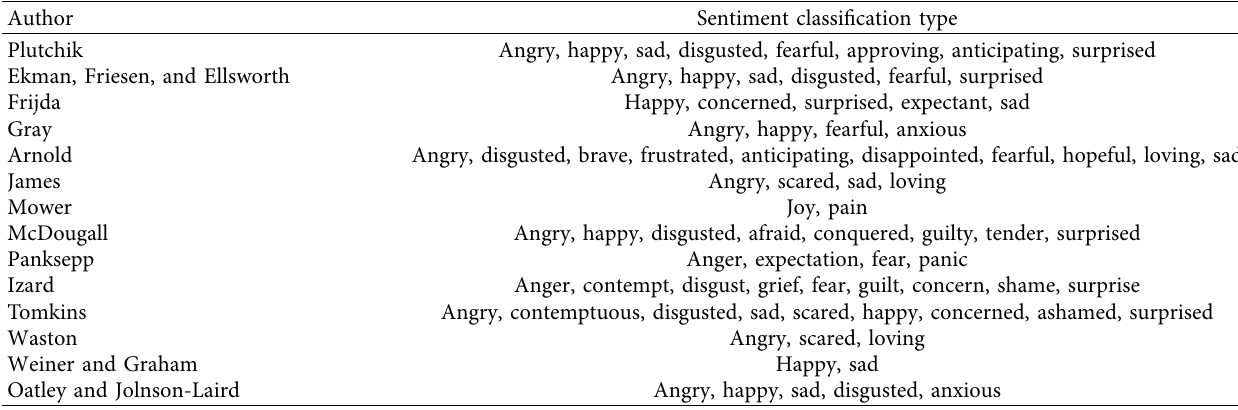
Table 1: Discrete emotion partition details.